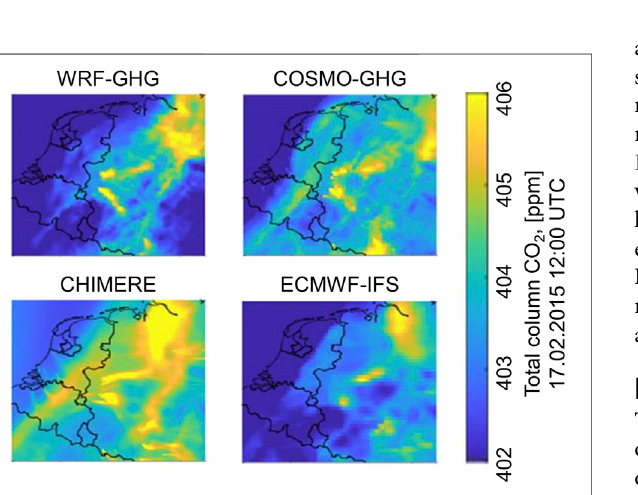
Frontiers in Remote Sensing |